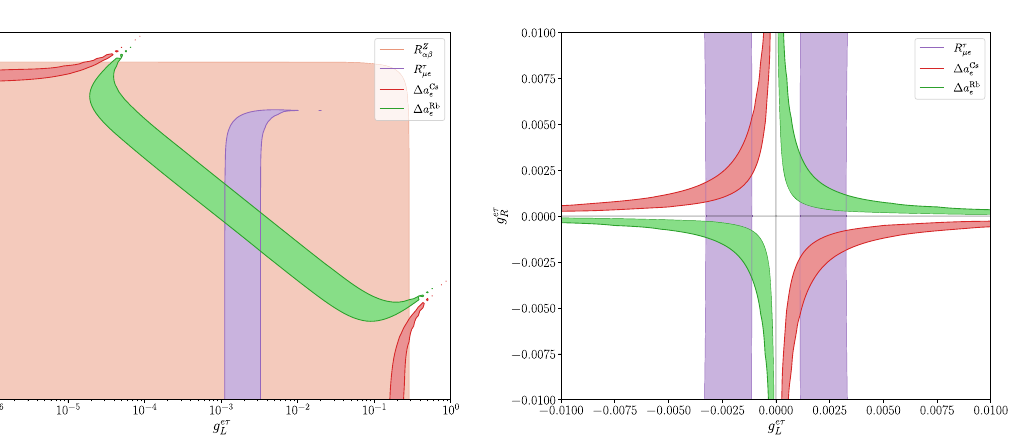
- g e τ ) parameter space, in agreement with the experimental sign ( g e τ L R bounds on LFU Z decay ratios (light orange) and R τ μ e (purple). On the right, detailed (linear) view of the viable g e τ